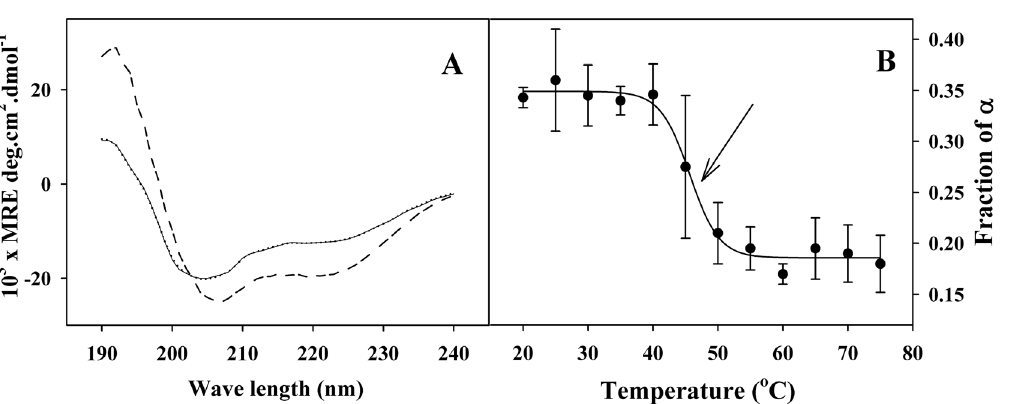
Fig. 1. Circular dichroism spectroscopy. A) Far-UV CD spectra of C-214-HrpZ Pss (solid line) and full length HrpZ Pss (dashed line) at 25 ˚ C. The dotted line corresponds to the calculated fit obtained by using the CDSSTR program for C-214-HrpZ Pss . B) Temperature dependence of a -helical content in C-214- HrpZ Pss .